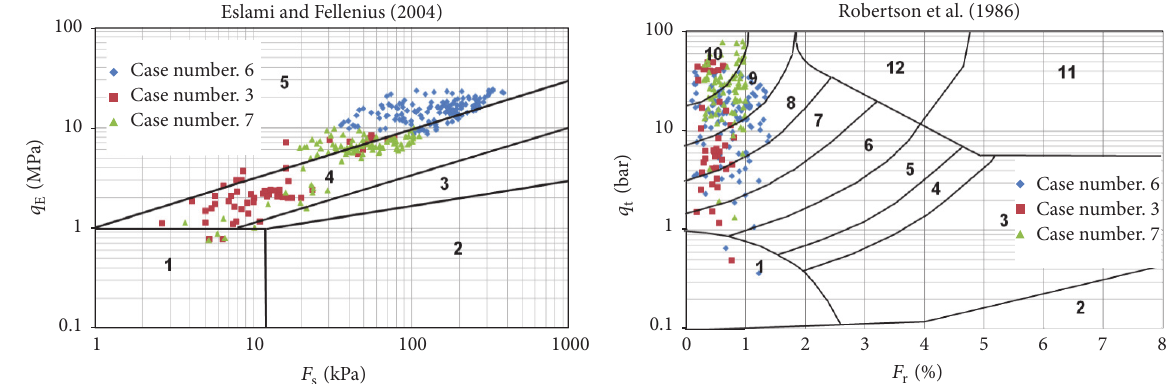
Figure 13: Location of CPT records of the evaluated sites before soil improvement via Eslami and Fellenius, 2004, and Robertson et al., 1986, charts. 1—clay silt (sensitive), 2—clay silt, 3—silty clay, 4—silty sand, 5—sand, 6—sandy silt to clayey silt, 7—silty sand to sandy silt, 8—sand to silty sand, 9—sand, and 10—sandy gravel to sand.